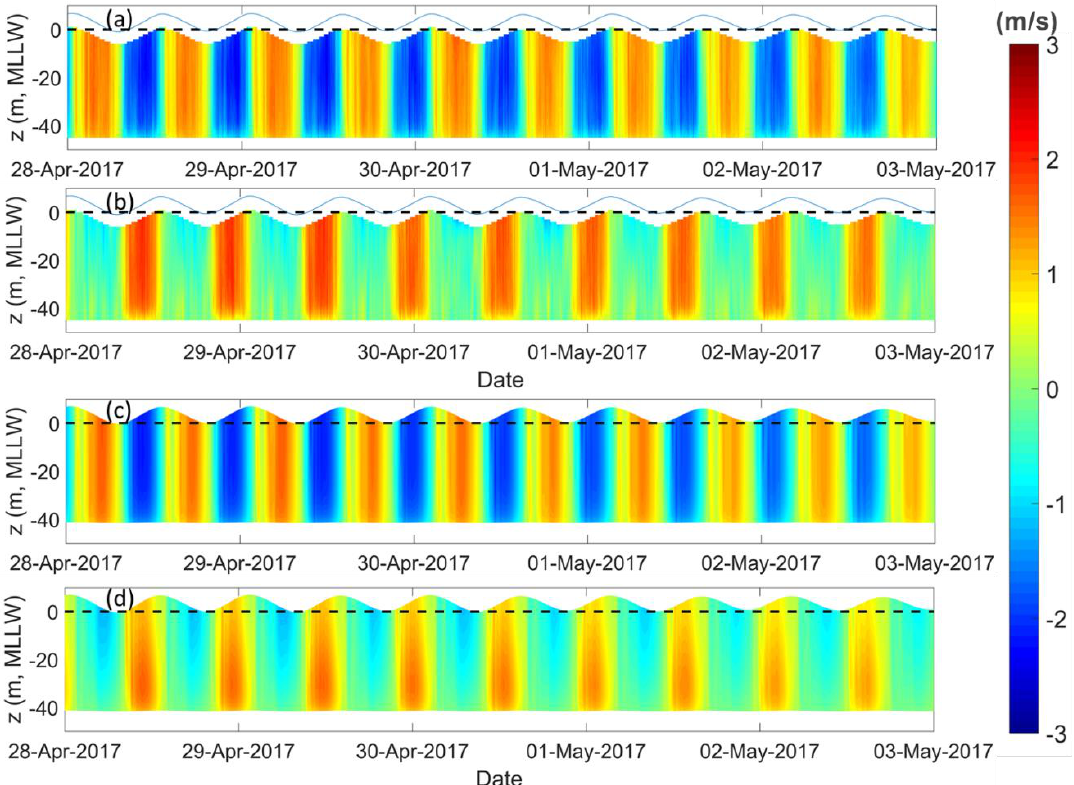
Figure 6. Comparison of the observed and modeled velocity time series through the water column at station WP1 in the Western Passage. ( a , b ) The observed east (u) and north (v) velocity components; ( c , d ) the modeled east (u) and north (v) velocity components.